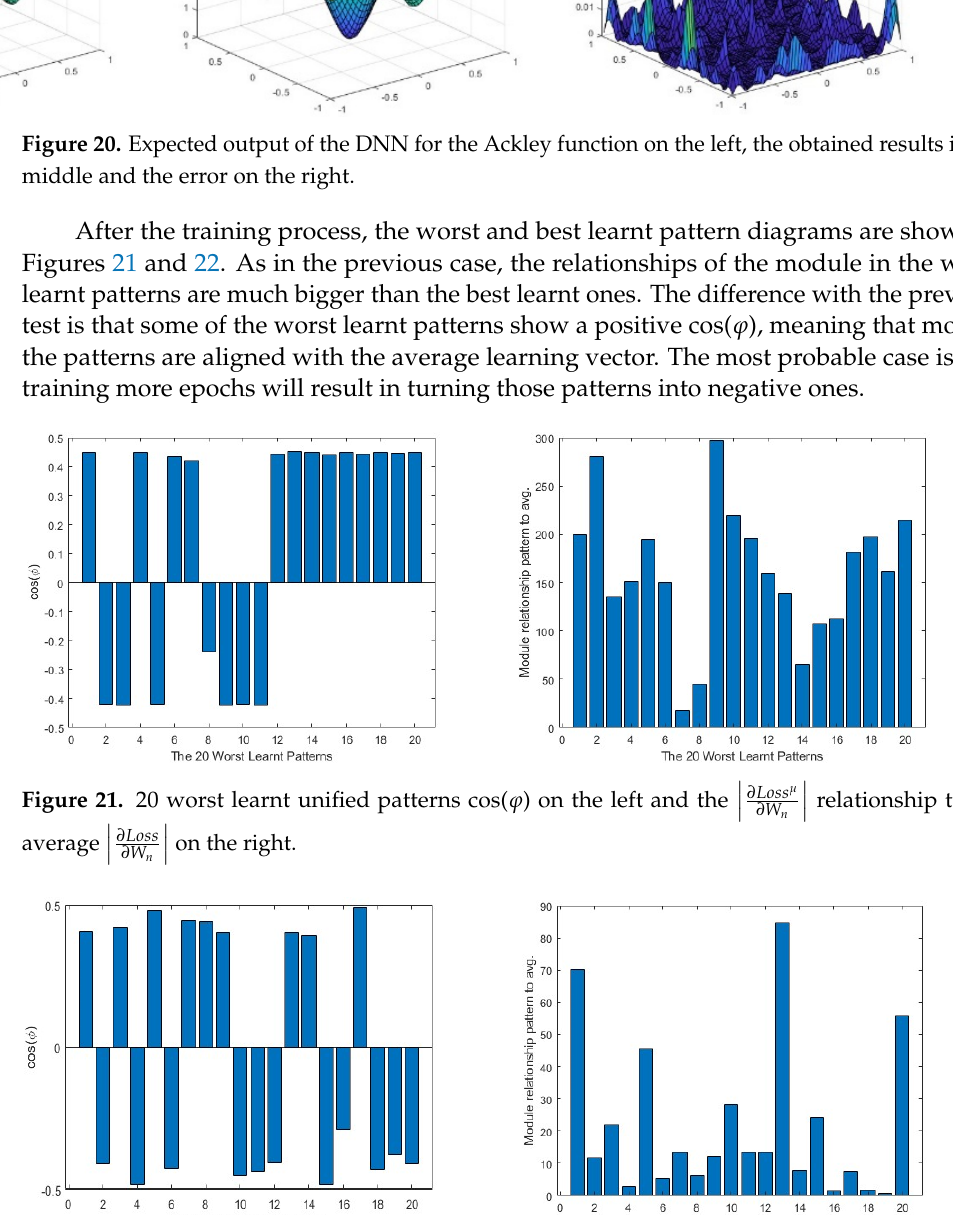
(cid:3339) (cid:4698) relationship to the aver- (cid:3105)(cid:3024) (cid:3289)